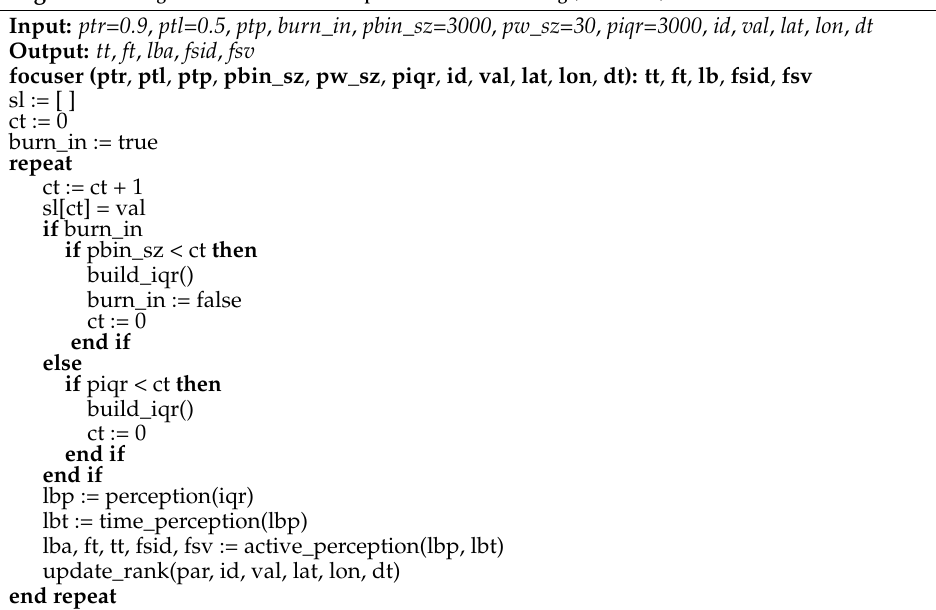
Algorithm 1 Fog Online Context-aware Up-to-date Sensor Ranking (FOCUSeR)